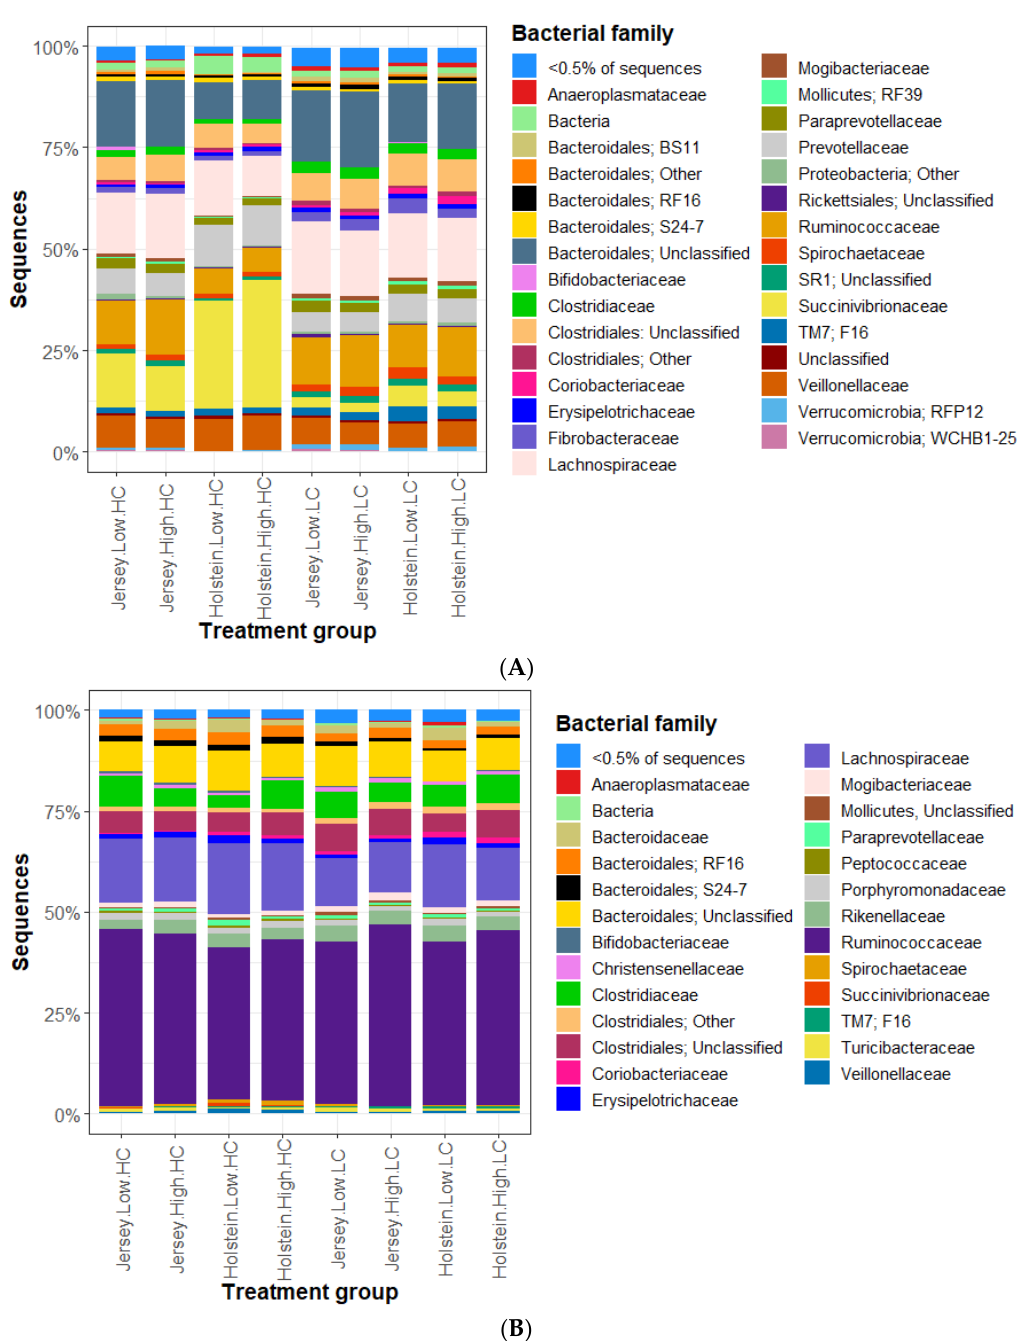
Figure 2. Histogram on relative abundance of bacterial community members in rumen ( A ) and feces ( B ) grouped by breed (Holstein or Jersey), residual feed intake (RFI) group (high or low), and diet (high concentrate: HC; and low concentrate: LC) combinations. Relative abundances are presented at the family or lowest defined level. Genera marked with ’unclassified’ matched to an unclassified sequence, whereas ‘other’ could not be assigned to a group, because there was no close match in the greengenes database.